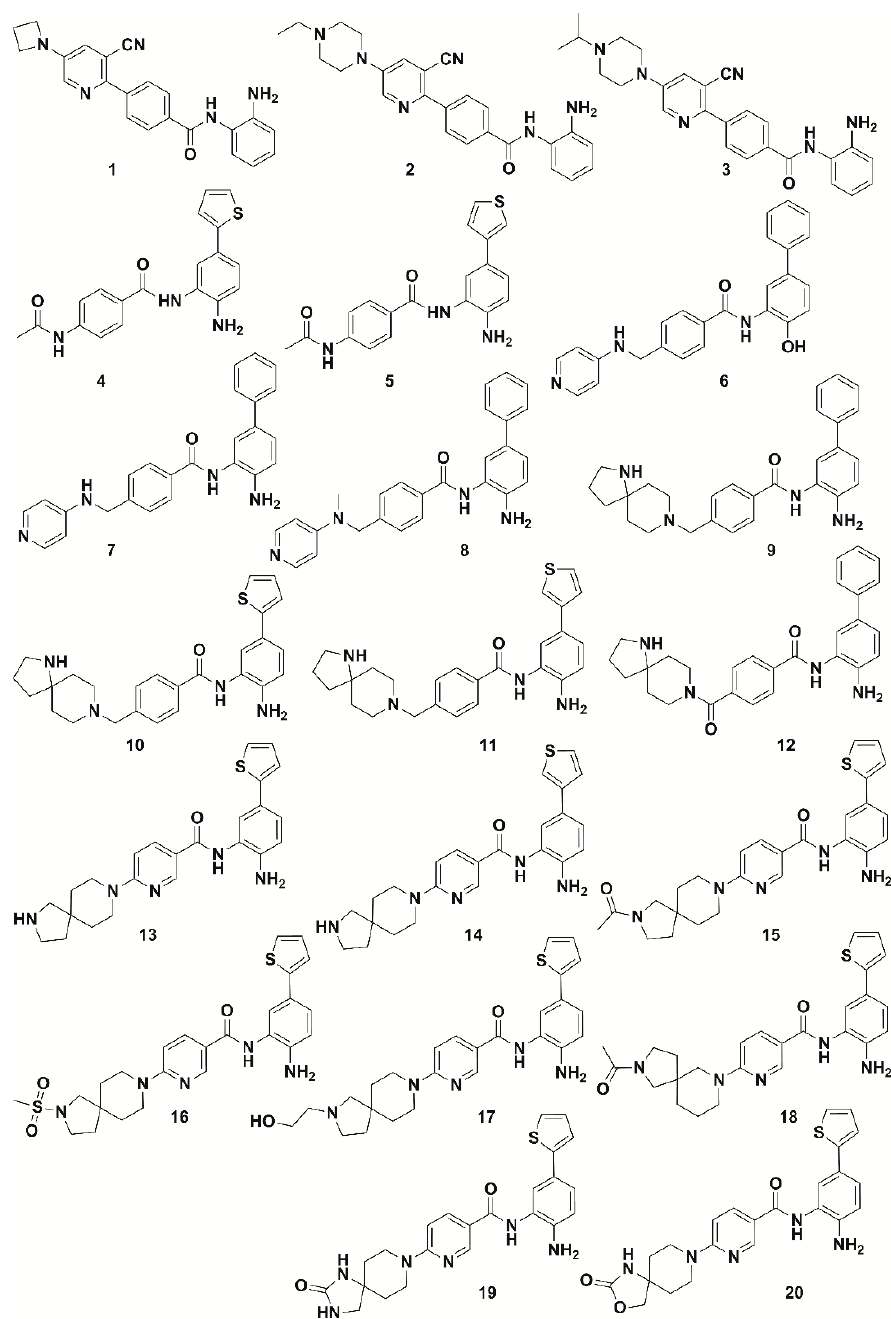
Figure 2. Chemical structure of highly active compounds against HDAC1 (IC 50 comprised between 0.004 µM and 0.01 µM) used for generating a common-features pharmacophore. 0.004 µ M and 0.01 µ M) used for generating a common-features